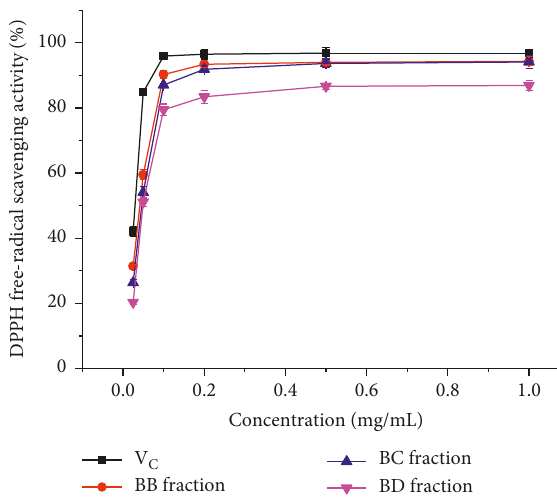
Figure 3: DPPH-scavenging activity of V fractions.